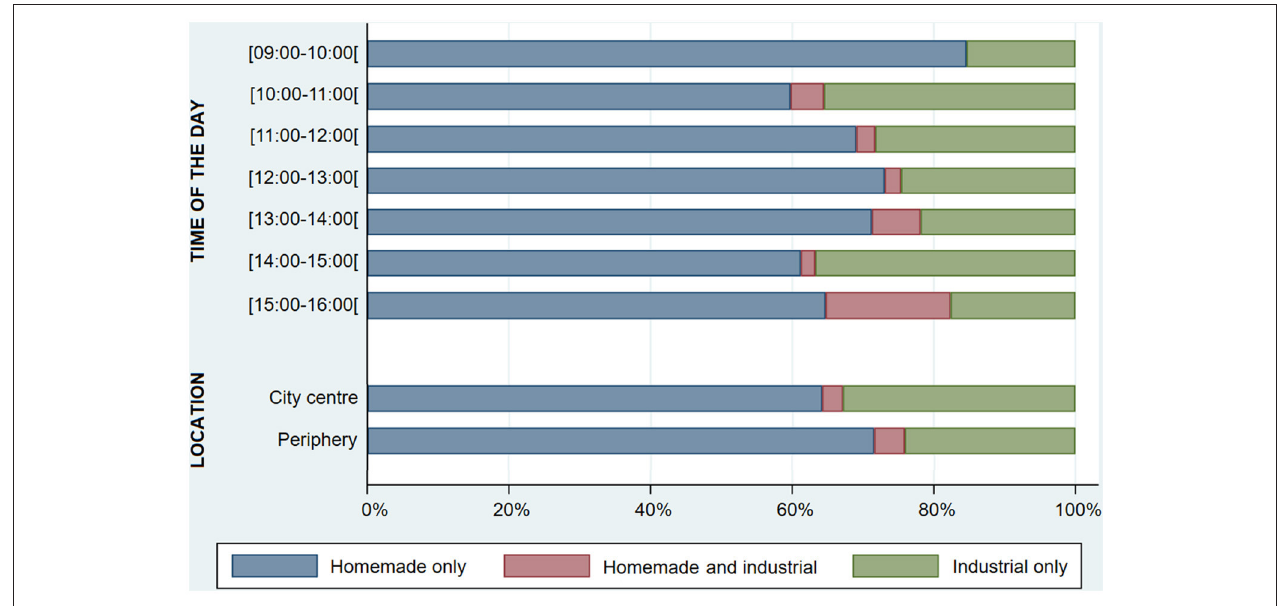
FIGURE 5 | Proportion of customers purchasing homemade and/or industrial food items, throughout the day and by city location ( n =